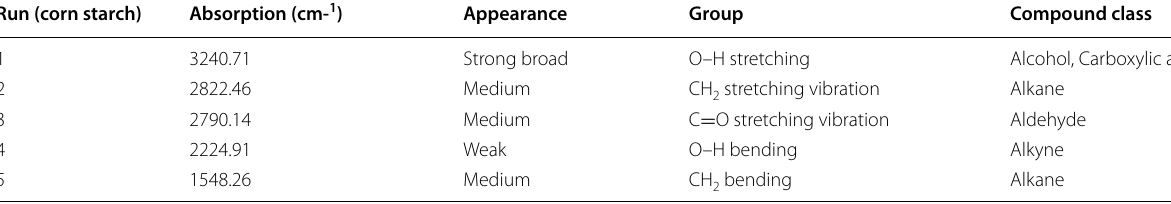
Table 2 FTIR analysis spectra for corn starch (A2) microcapsules Run (corn starch)